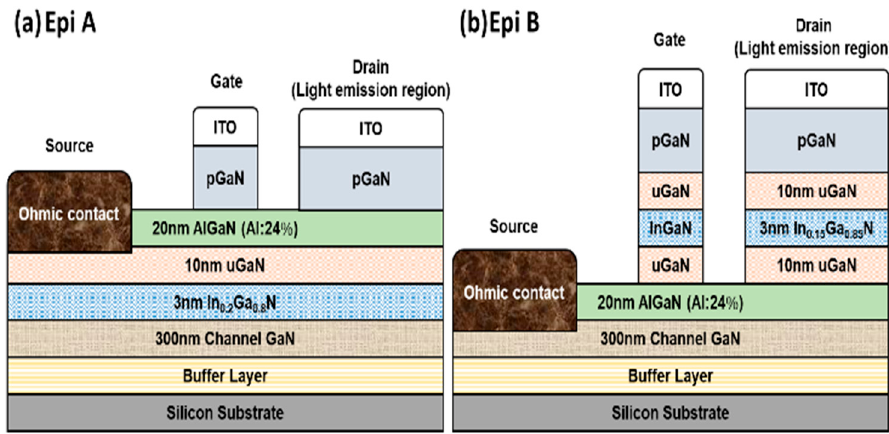
Figure 1. Schematic cross-sectional view of AlGaN/GaN LE-HEMTs fabricated on ( a ) Epi A and ( b ) Epi B structures . and ( b ) Epi B